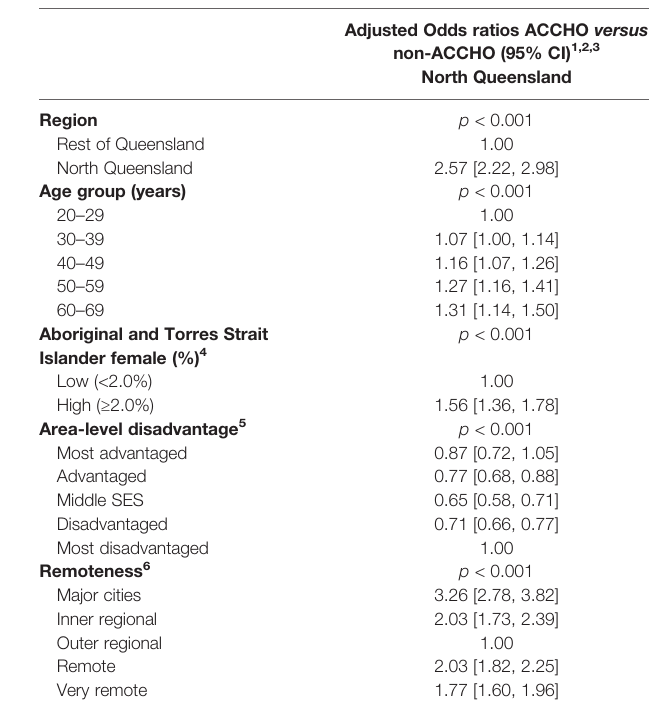
TABLE 4 | Participation rate ratios (PRRs) [95% CI] for cervical screening by region, for Aboriginal and Torres Strait Islander women aged 20 – 69 years, Queensland, Australia, 2013 – 2017.